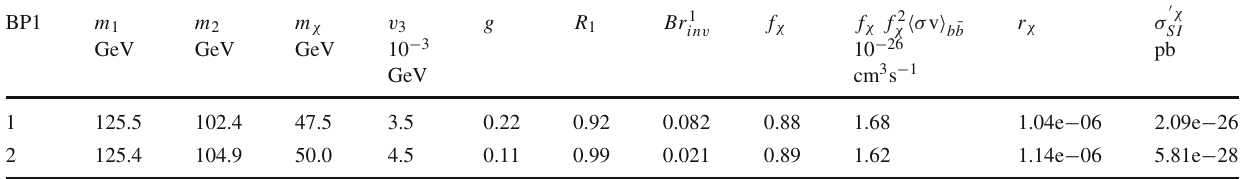
Table 3 Benchmark points for calculation of GC gamma ray excess plotted in Fig. 5 with fermionic dark matter χ